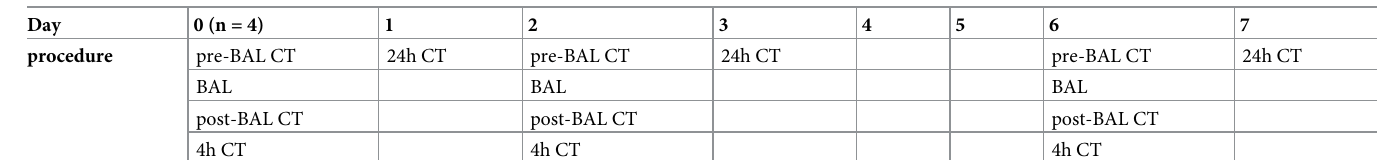
Table 1. Timeline of the procedures in healthy, non-infected, animals.